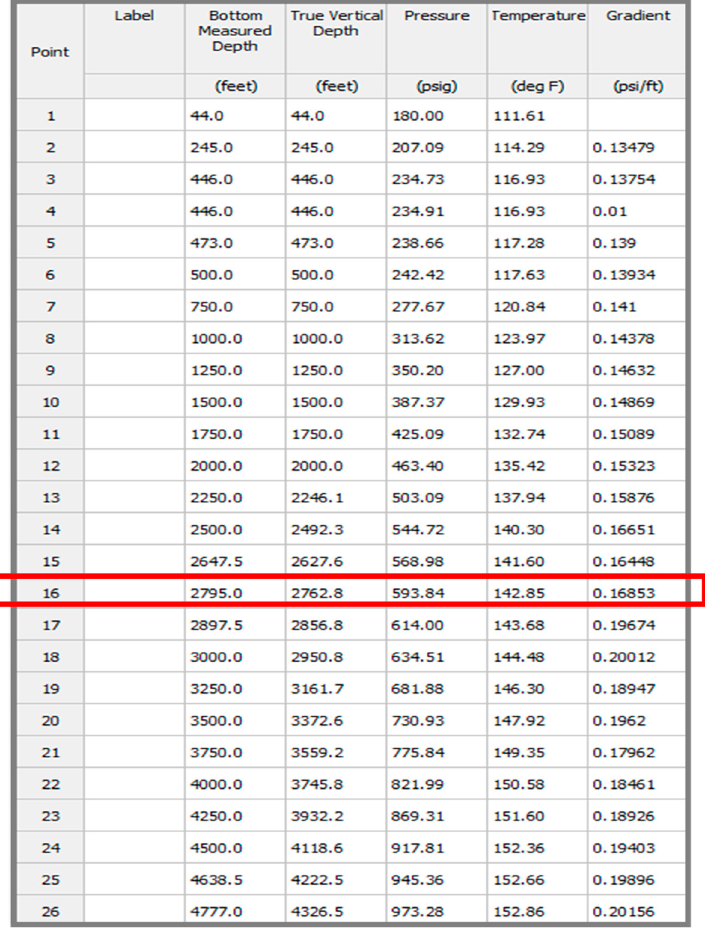
Figure 9. Pressure gradient calculation with PROSPER.